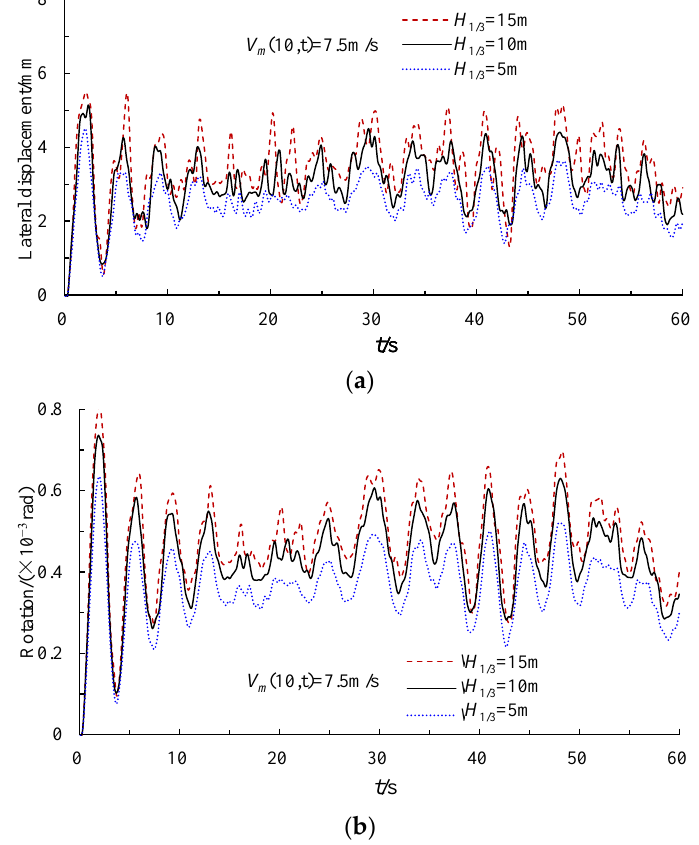
Figure 21. Dynamic response of the GBF under combined wind and wave loads: ( a ) lateral displacement; ( b ) rotation angle.